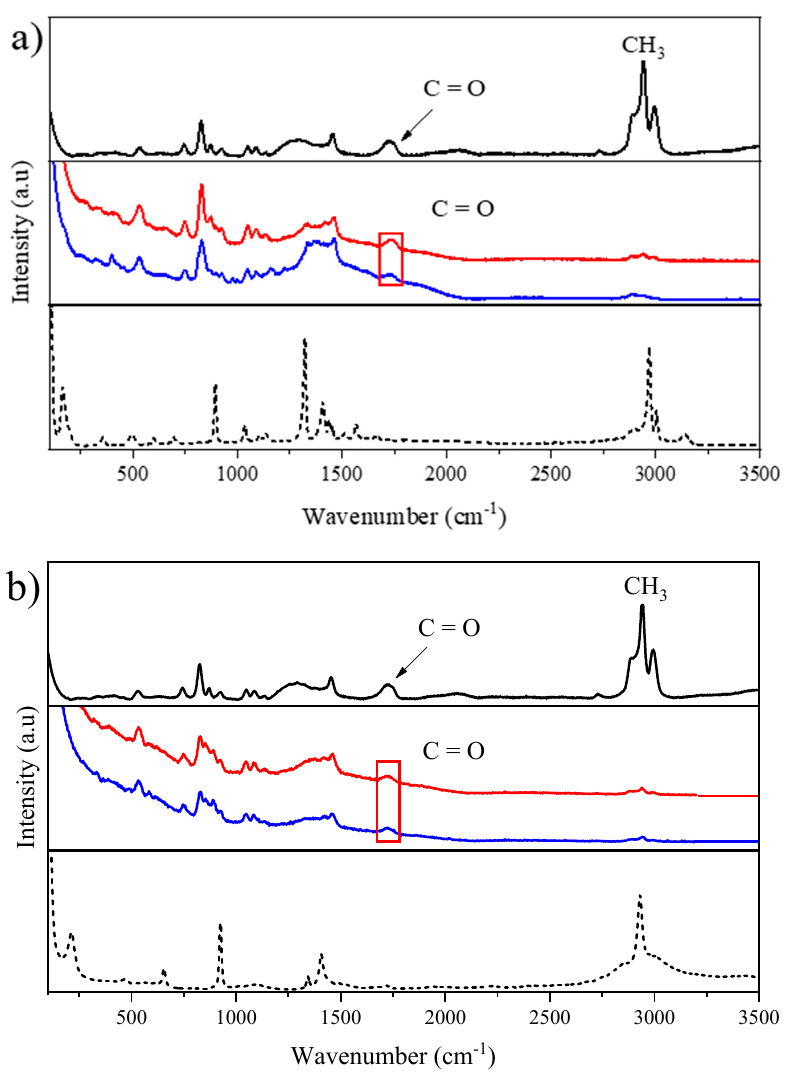
Figure 6. ( a ) Spectra (FTIR) of the pure components — (black line) lactic acid, ---- (dashed line) glycine, — (red line) NADESs without water; — (blue line) NADESs with water. ( b ) Raman spectra of the pure components — (black line) lactic acid lactic acid, ---- (dashed line) ammonium acetate, — (red line) NADESs without water; — (blue line) NADESs with water.